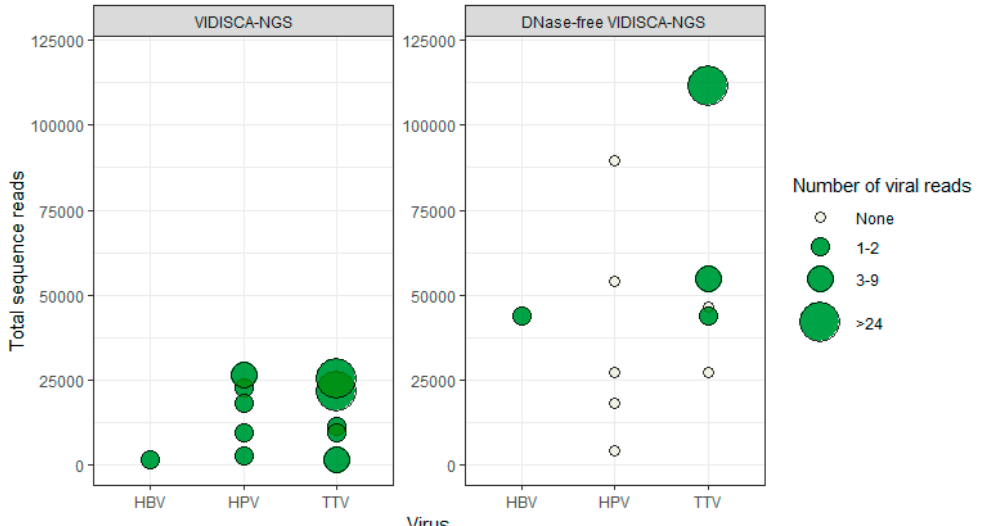
Figure 4. E ff ect of DNase on the detection of non-herpes DNA viruses by VIDISCA-NGS. On the x-axis, the viral species is displayed; on the y-axis, the total number of sequence reads. Left panel: Normal VIDISCA-NGS, right panel: DNase-free VIDSCA-NGS. Green dots: samples positive for the indicated virus, white dots: samples negative for the indicated virus. The size of the dots corresponds to the number of viral reads.